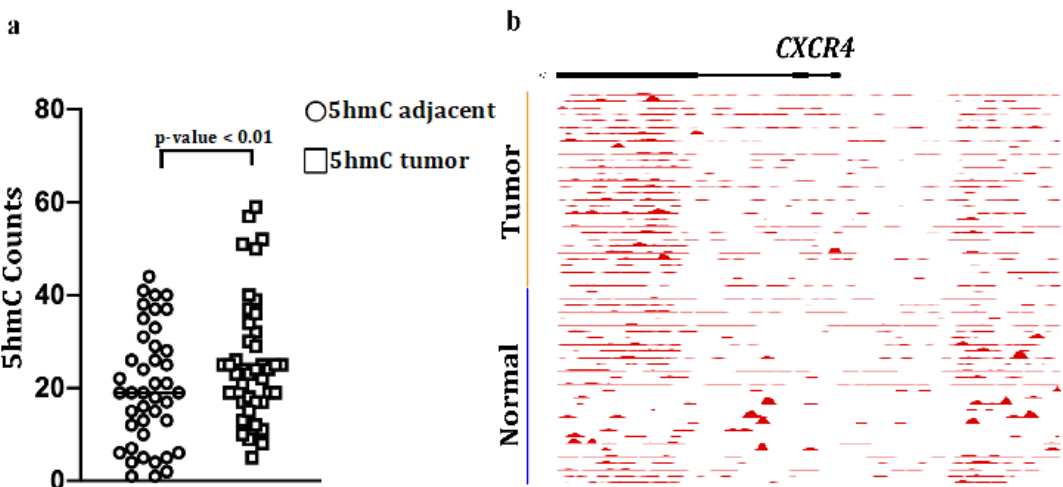
Figure 6. 5-hydroxymethylcytosine (5hmC) abundance in CXCR4 gene bodies in colon cancers and matched adjacent mucosa (n = 42 samples, p < 0.01, paired Student’s t -test): ( a ) Counts per million reads at CXCR4 gene, ( b ) plus promoter (upstream 3kb region) in matched tumors and adjacent healthy tissue in 30 colorectal cancer patients. The moving averages at 0.01 smoother span are shown. Black bars mark